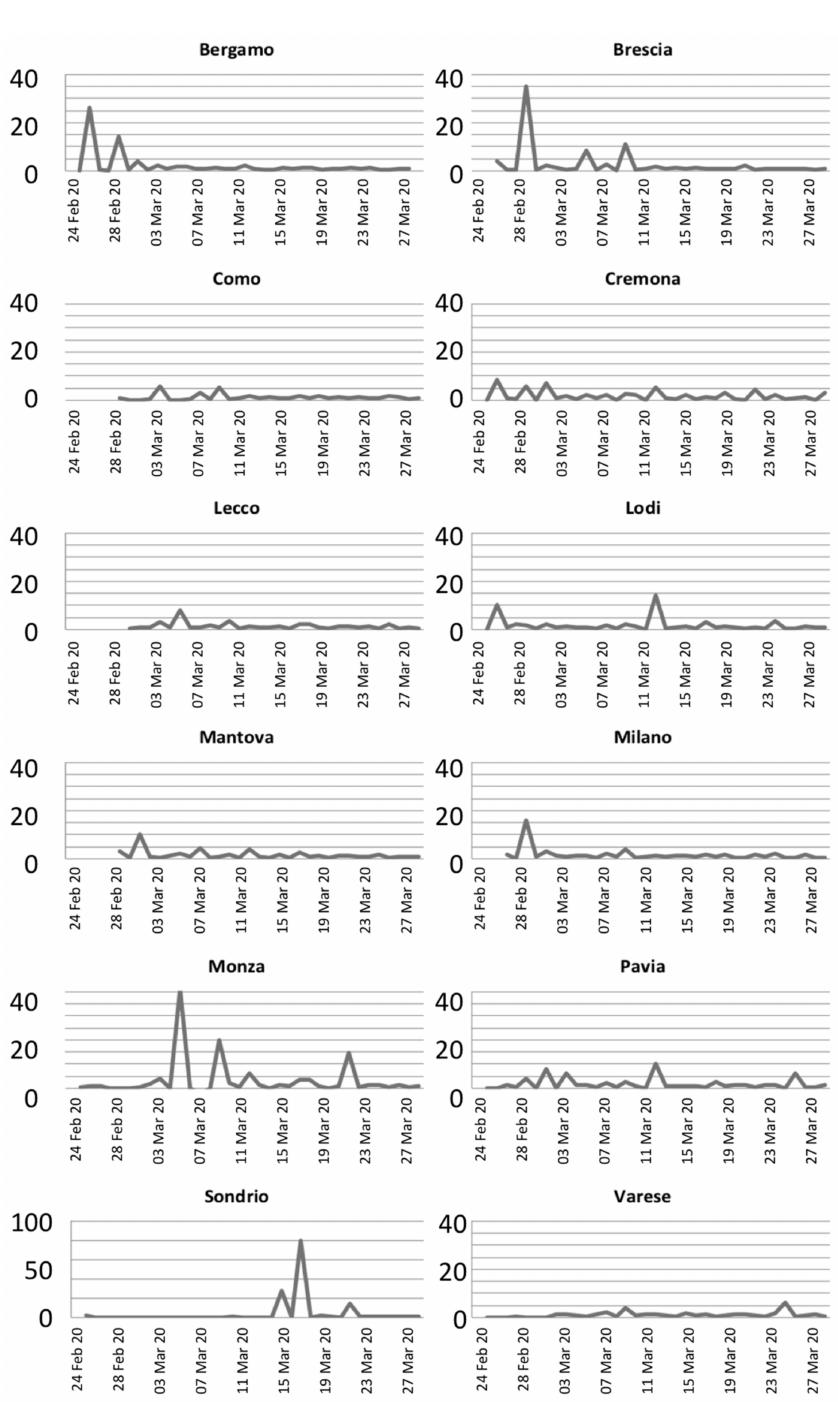
Figure 2. Growth rates of the infection on divided per